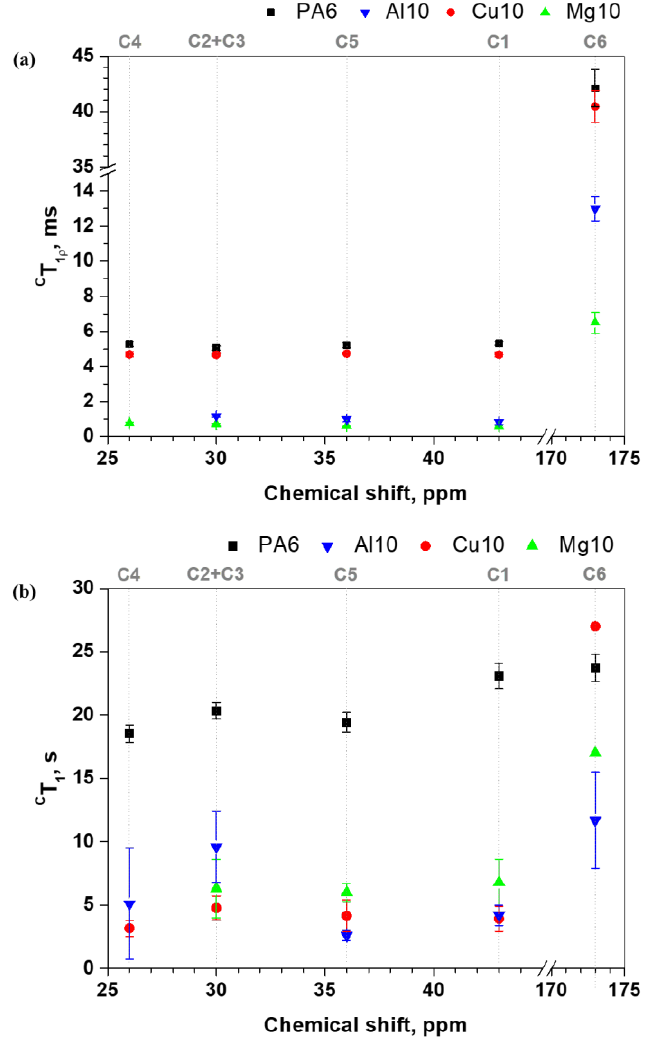
Figure 6. ( a ) C T 1ρ and ( b ) C T 1 of the carbon nuclei in empty and Me-MP samples.